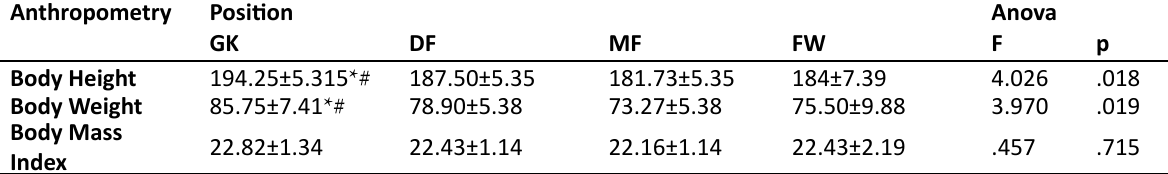
Table 2. Differences in the anthropometric characteristics of the football player - Anova, Post Hoc Anthropometry